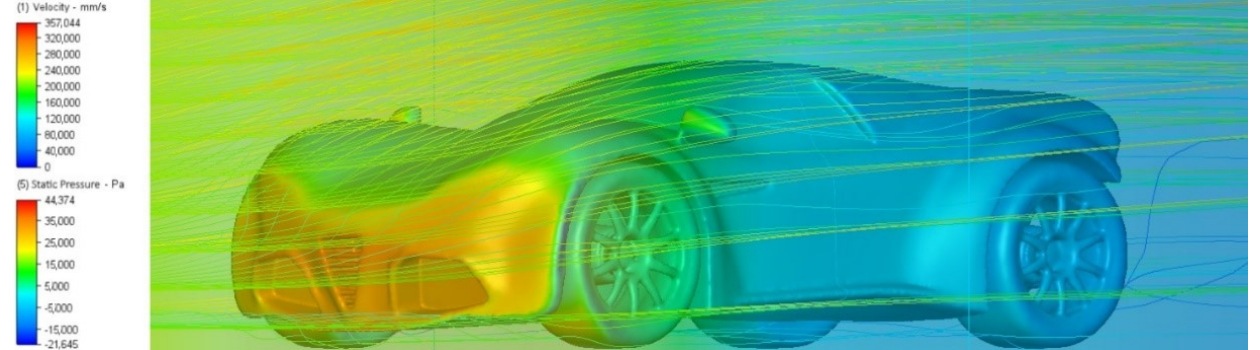
Figure 34. Natural concept CFD Analysis.